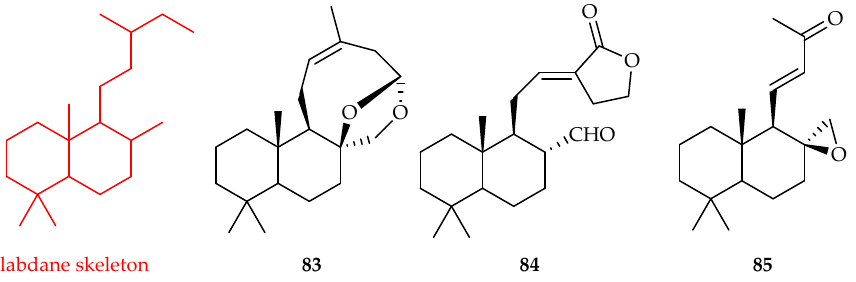
Figure 34. Structures of galangalditerpenes A–C 83–85 [52].